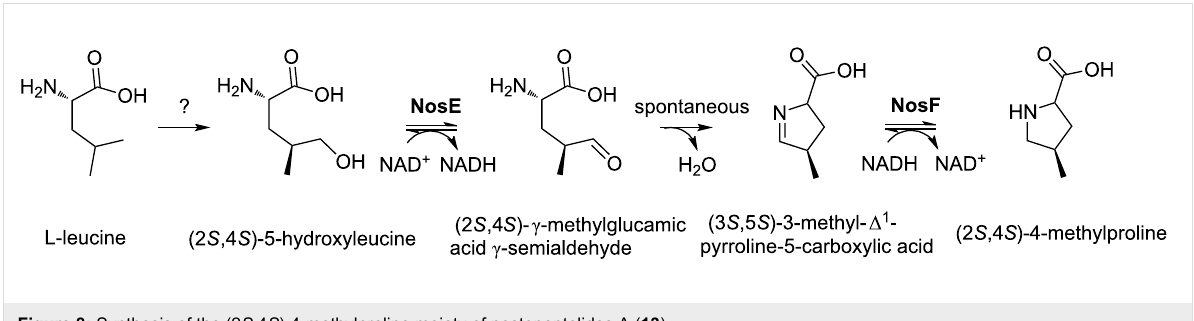
Figure 8: Synthesis of the (2 S ,4 S )-4-methylproline moiety of nostopeptolides A ( 13 ).